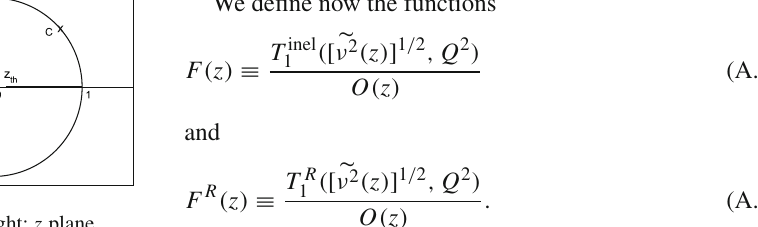
Fig. 4 Conformal mapping (A.1). Left: ν 2 plane. Right: z